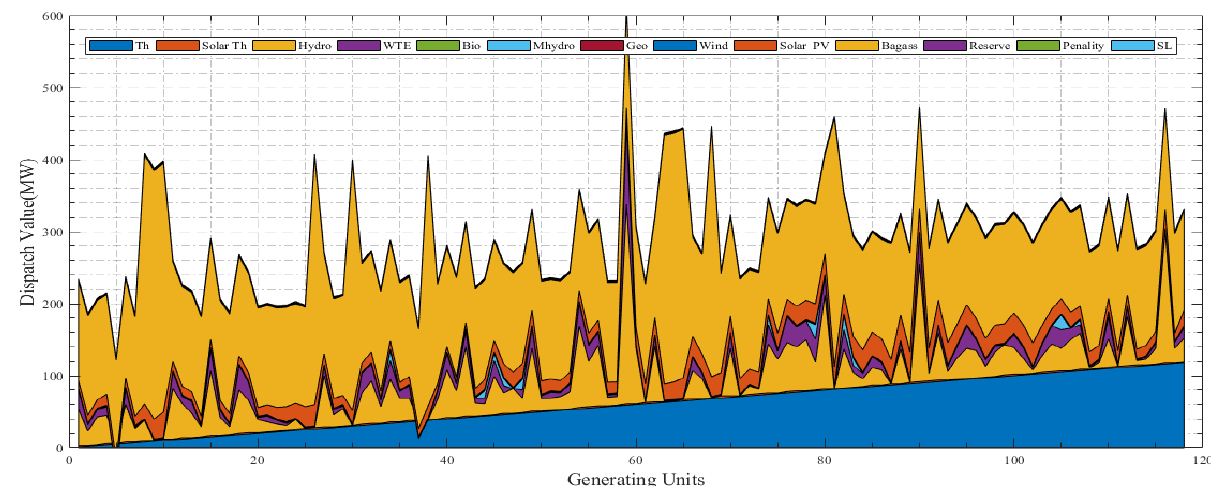
Figure 7 . Dispatch value of generating units by